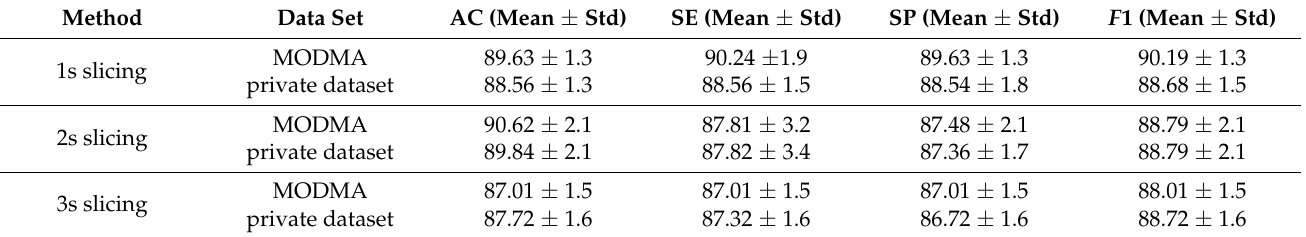
Table 2. Comparisonoftheclassificationresultsoftheproposedmethodusingthedataaugmentationprocedure.